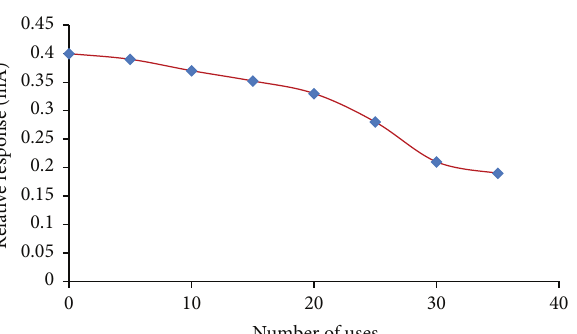
Figure 13: Reusability of the present method.